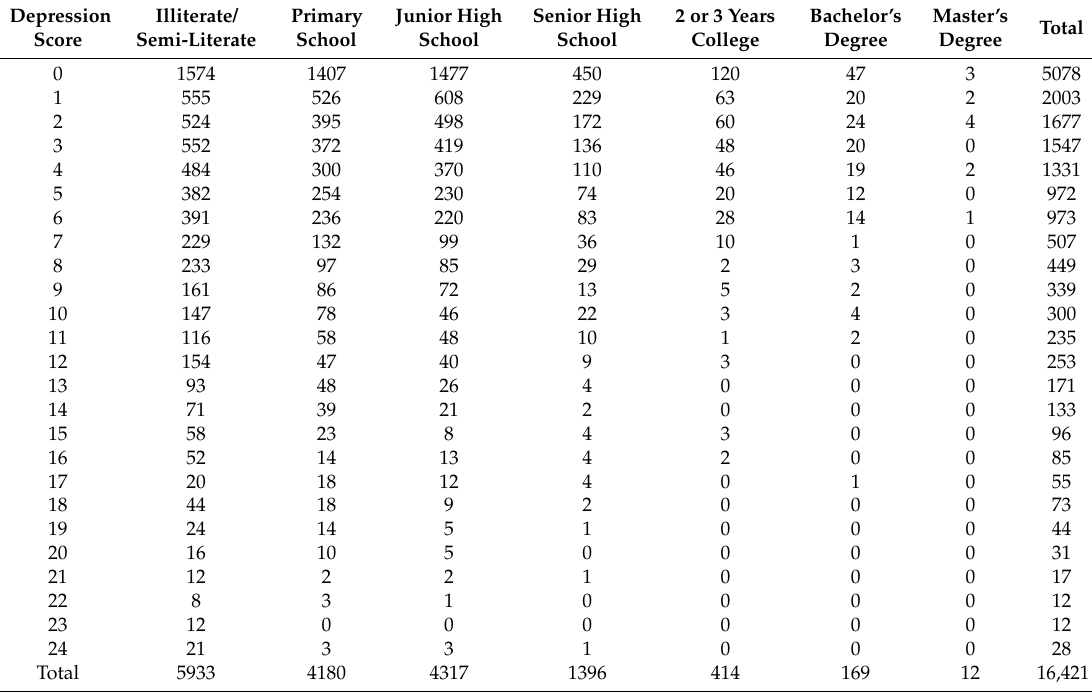
Table A1. Cross analysis of education and depression